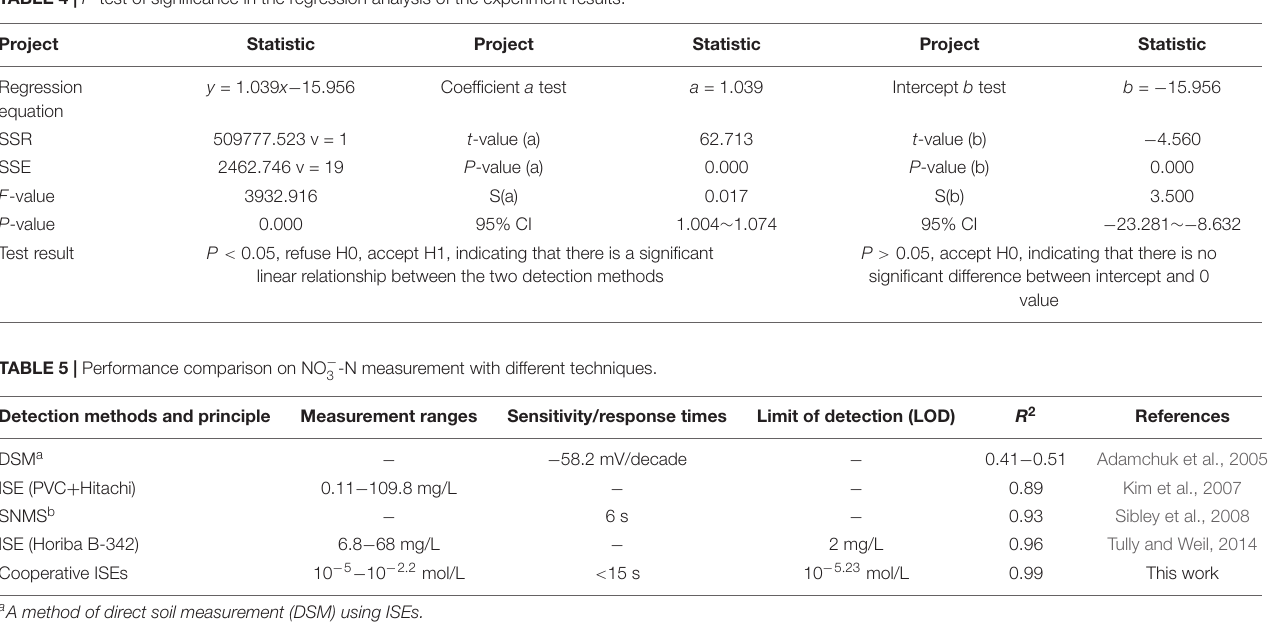
TABLE 4 | F -test of significance in the regression analysis of the experiment results.